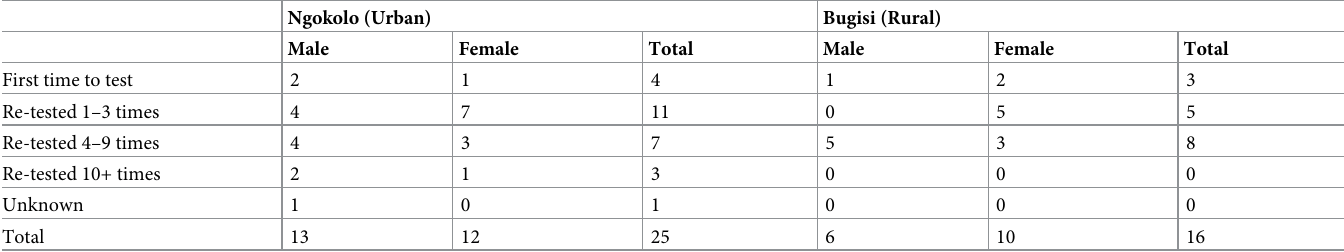
Table 1. Testing characteristics participants rapid interviews (n = 41).